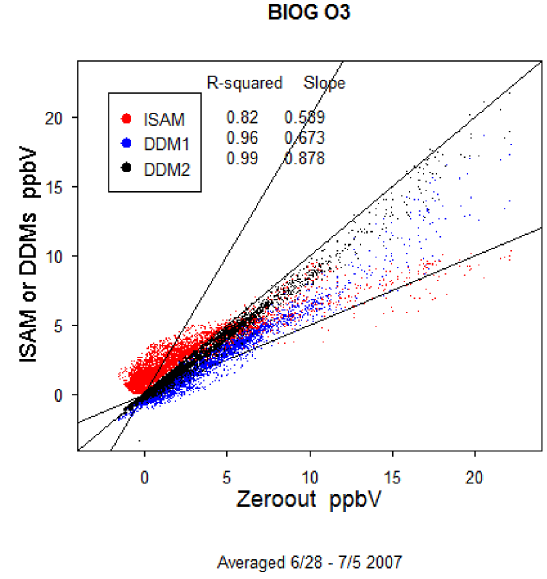
Figure 5. Scatter plots of biogenic O 3 with respect to the zero-out brute force, sampled on all-hour-averaged data. Red: ISAM, blue: first-order decoupled direct method (DDM1), black: second-order decoupled direct method (DDM2). The corresponding R squared values and regression slopes are also